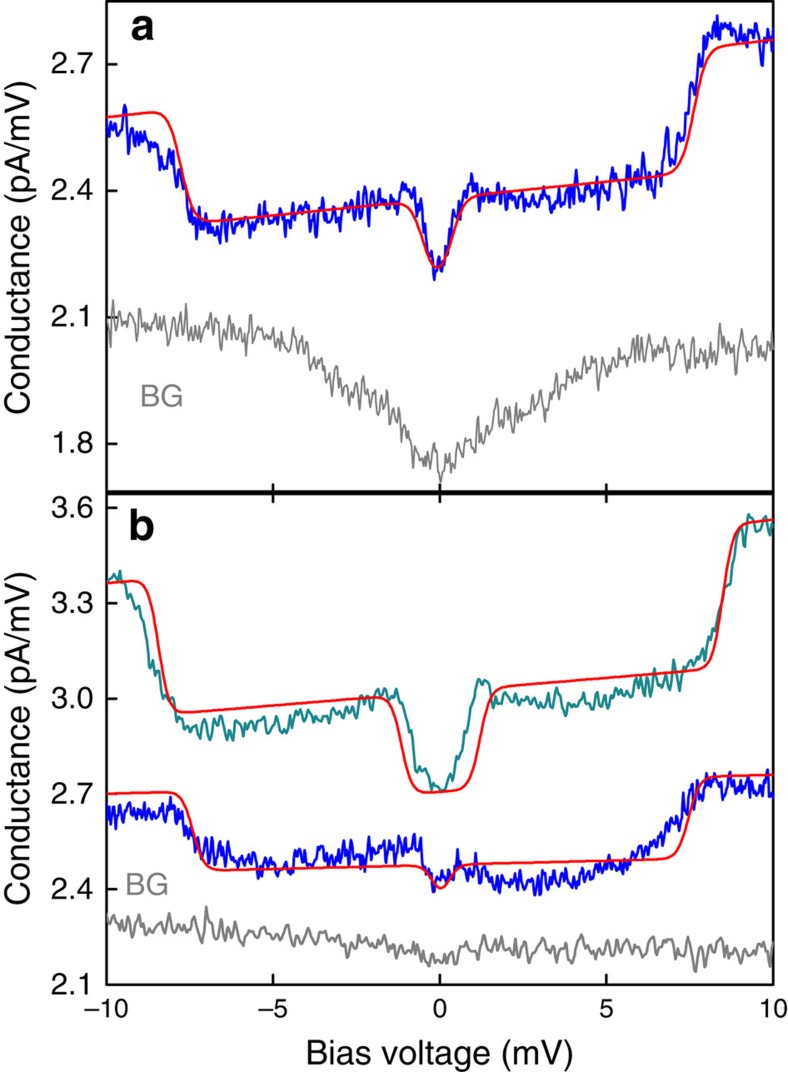
Conductance spectra of individual molecules.(a) dI/dV(V) spectrum recorded on a molecule with 700 pm topographic height at 0 T magnetic field (blue line, initial current Io=75 pA at Vo=10 mV). A background (BG) spectrum recorded with the same tip on bare Cu2N is shown in grey. (b) Spectra acquired on a single molecule (800 pm height) without magnetic field (blue line, Io=25 pA, Vo=10 mV) and under a 9 T out-of-plane field (green line, Io=50 pA, Vo=15 mV), background spectrum (BG, grey line). When a magnetic field is applied, the low-energy excitation widens from 0.2±0.2 to 0.8±0.1 mV and the high-energy excitation widens from 7.5±0.1 to 8.5±0.1 mV. Background spectra in (a) and (b) are offset for clarity. Red lines in (a) and (b) indicate spectra computed using the spin Hamiltonian model. The fits yield exchange coupling, J=2.93 meV (23.6 cm−1), and magnetic anisotropy, D=−52 μeV (−0.42 cm−1) for the molecule in (a) and J=2.89 meV (23.3 cm−1), D=−26 μeV (−0.21 cm−1) with a g factor of 2 for the molecule in (b).